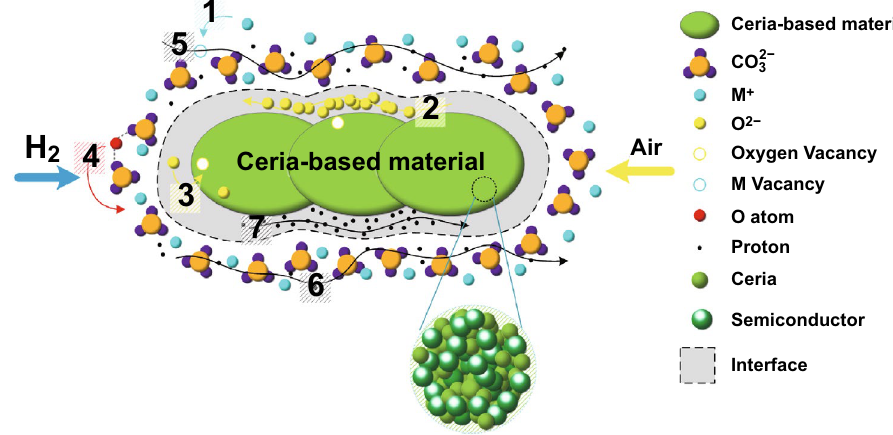
Fig. 5 Cogwheel mechanism for the migration of (1) cations (M + ) of the carbonate, (2) oxide (O 2− ) anions of the oxide at the interface, (3) the oxide anions at bulk, (4) neutral O in the carbonate (CO 32− ), (5) proton with the help of M + vacancy, (6) proton in carbonate and (7) the bond chain at the interface in ceria‑based